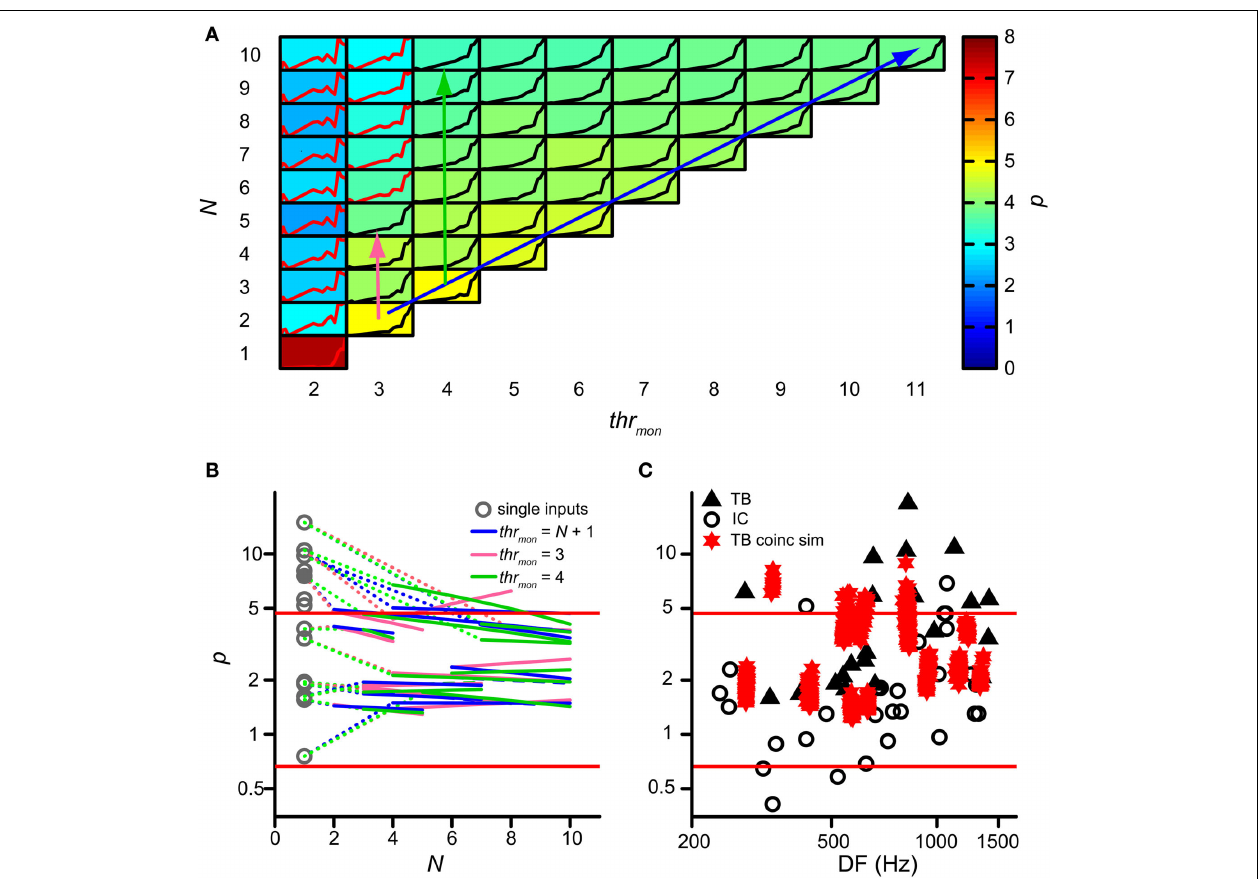
FIGURE 7 | Effect of convergence of inputs on p of rICF. (A) Set of simulations for one TB dataset (same as in Figure 4 ). N and thr mon are varied; thr bin = 2 and cw = 50 μ s. In each subplot the rICF corresponding to that combination of simulation parameters is shown. Black traces represent accepted simulation results. Subplot background color represents the power value. The abscissa in each plot ranges from − 1 to 1; the ordinate ranges from 0 to the maximum of the particular rICF. (B) TB population data showing change of power with convergence of inputs. Gray circles represent the